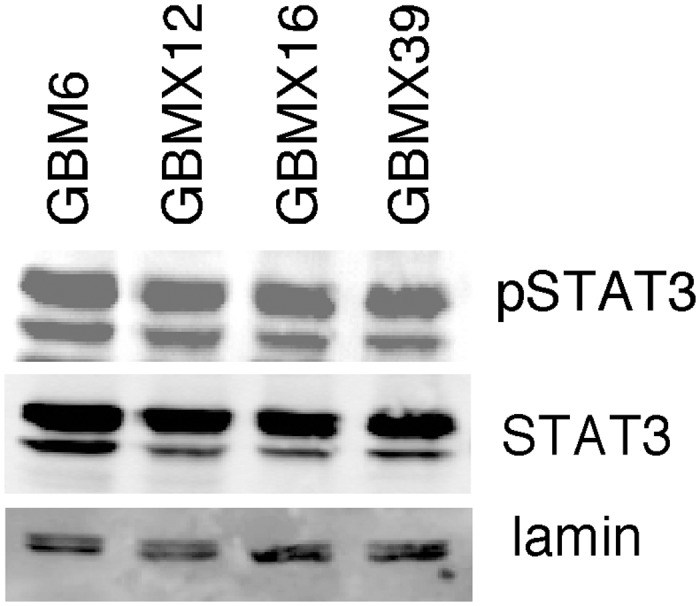
Constitutive activation of STAT3 in Ad-GSCs isolated from various GBM PDXs.The expression of STAT3 and pSTAT3 in nuclear extracts prepared from Ad-GSCs isolated from GBM6, GBMX12, GBMX16 and GBMX39 PDXs was determined by immunoblotting. Lamin expression served as a loading control.